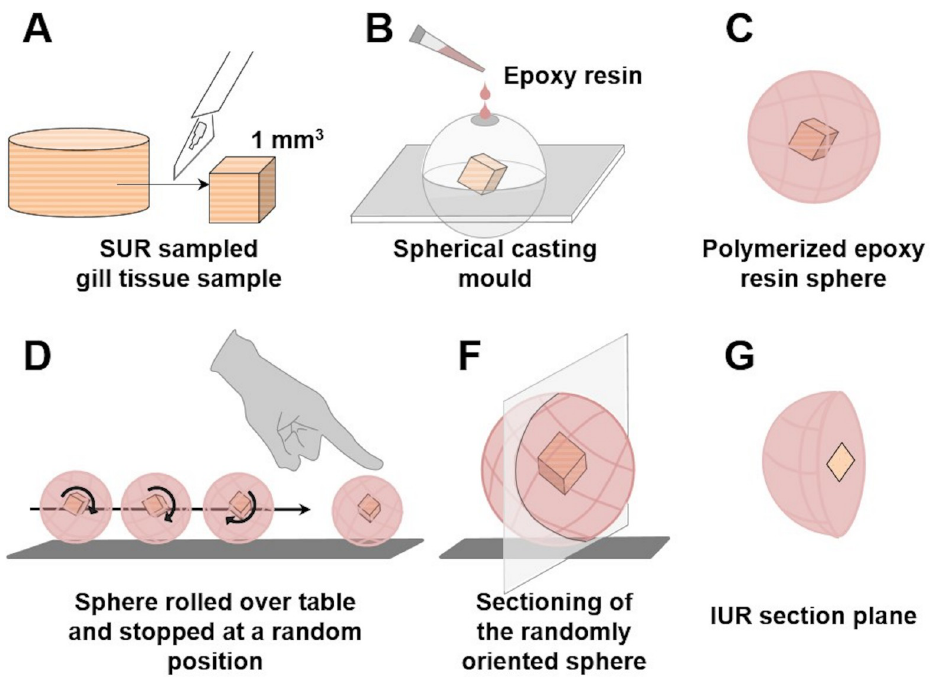
Fig 9. Generation of IUR sections of a SUR sampled gill filament specimen with the Isector method. A. A SUR sampled specimen of fixed gill filaments is carefully cut to a size of approximately 1 mm x 1 mm x 1 mm (suitable for Epon-embedding and electron microscopy), preserving the secondary lamellae as structure of interest. B. The specimen is embedded in a sphere of epoxy resin, using a spherical casting mould. C, D. After polymerization of the embedding medium, the sphere is rolled across a flat surface and stopped at a random position. F, G. The sphere is sectioned at this random position, resulting in an IUR section plane.